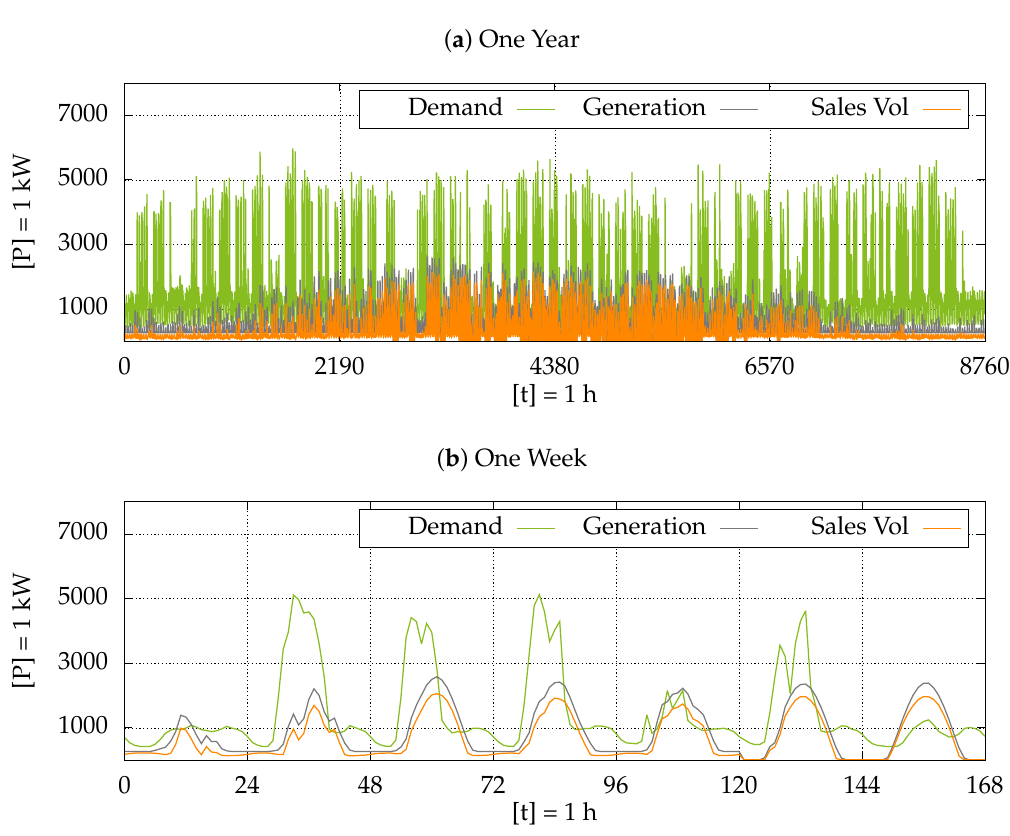
Figure 9. Green electricity demand, generation and sales volume in fix price scenario over ( a ) one year (1 January 2015– 31 December 2015) and ( b ) one week (18–24 May